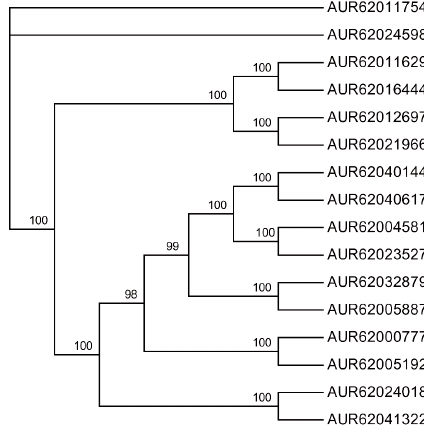
Figure 1. Phylogenetic tree of HSP70 in quinoa. Sixteen HSP70 homologs were identified in the proteome database of quinoa. Unrooted phylogenetic tree was constructed based on multiply-aligned sequences of the sixteen CqHSP70 protein homologs via PhyML using JTT substitution model with 1000 bootstrap replications as described in the method. Bootstrap values are indicated (in